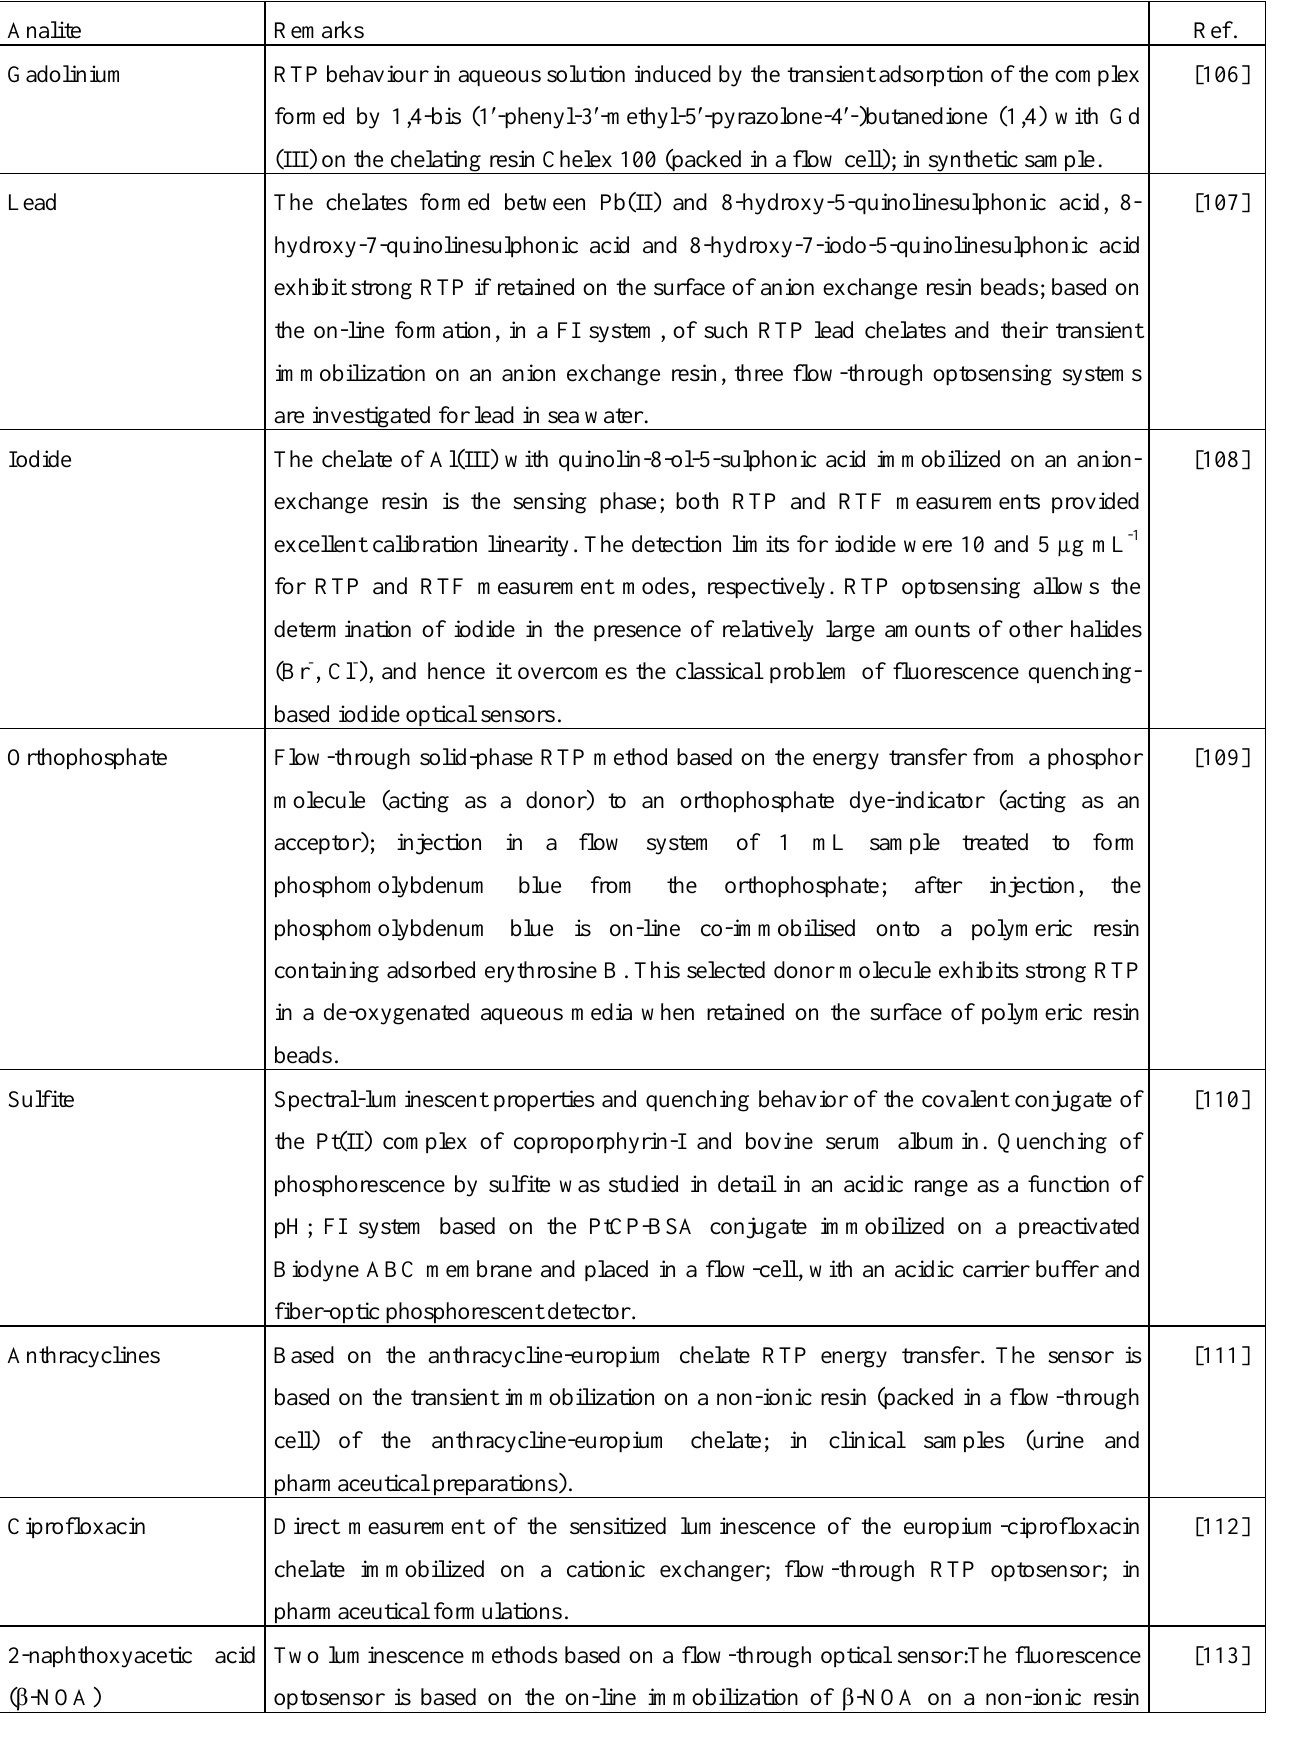
Table 2. Methods based on flow-through phosphorescence